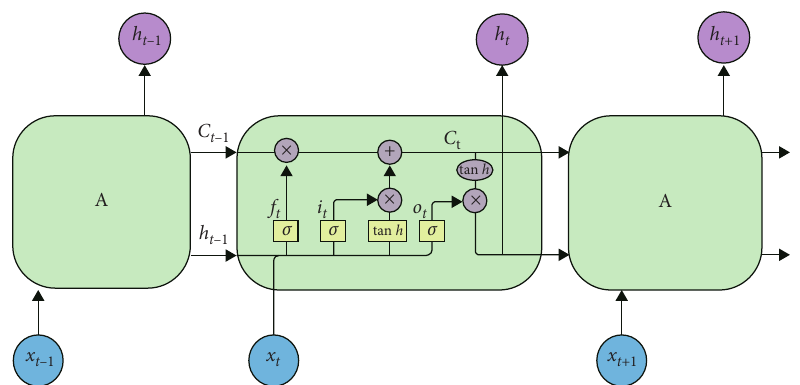
Figure 3: Illustrations of long short-term memory neural network.